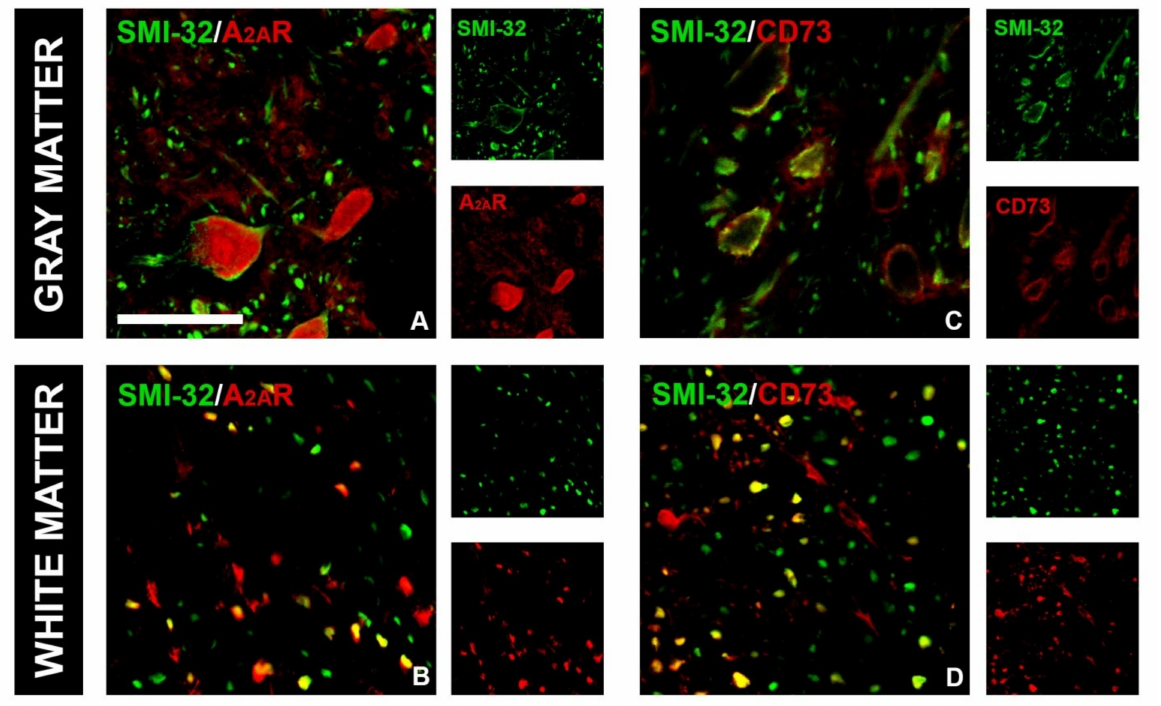
Figure 10. A 2A R and CD73 expression in gray and white matter in lumbar spinal cords of CTBS-treated rats. A 2A R signal was colocalized with SMI-32: in gray matter, co-staining was observed in neuronal soma ( A ), whereas in white matter, neuronal axons showed A 2A R immunoreactivity ( B ). CD73 signal was colocalized with SMI-32: in gray matter ( C ), whereas in white matter, neuronal axons showed SMI-32/CD73 colocalization ( D ). Scale bar corresponds to 50 µ